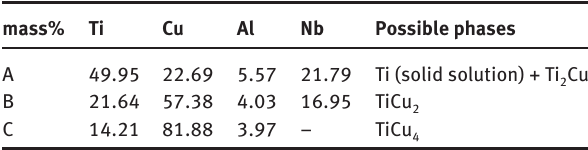
Table 1: Chemical analysis results of joints produced